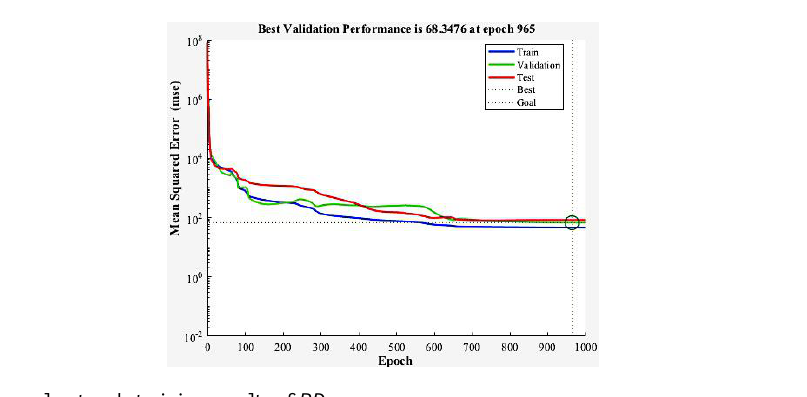
Fig. 5. Neural network training results of PD emp .